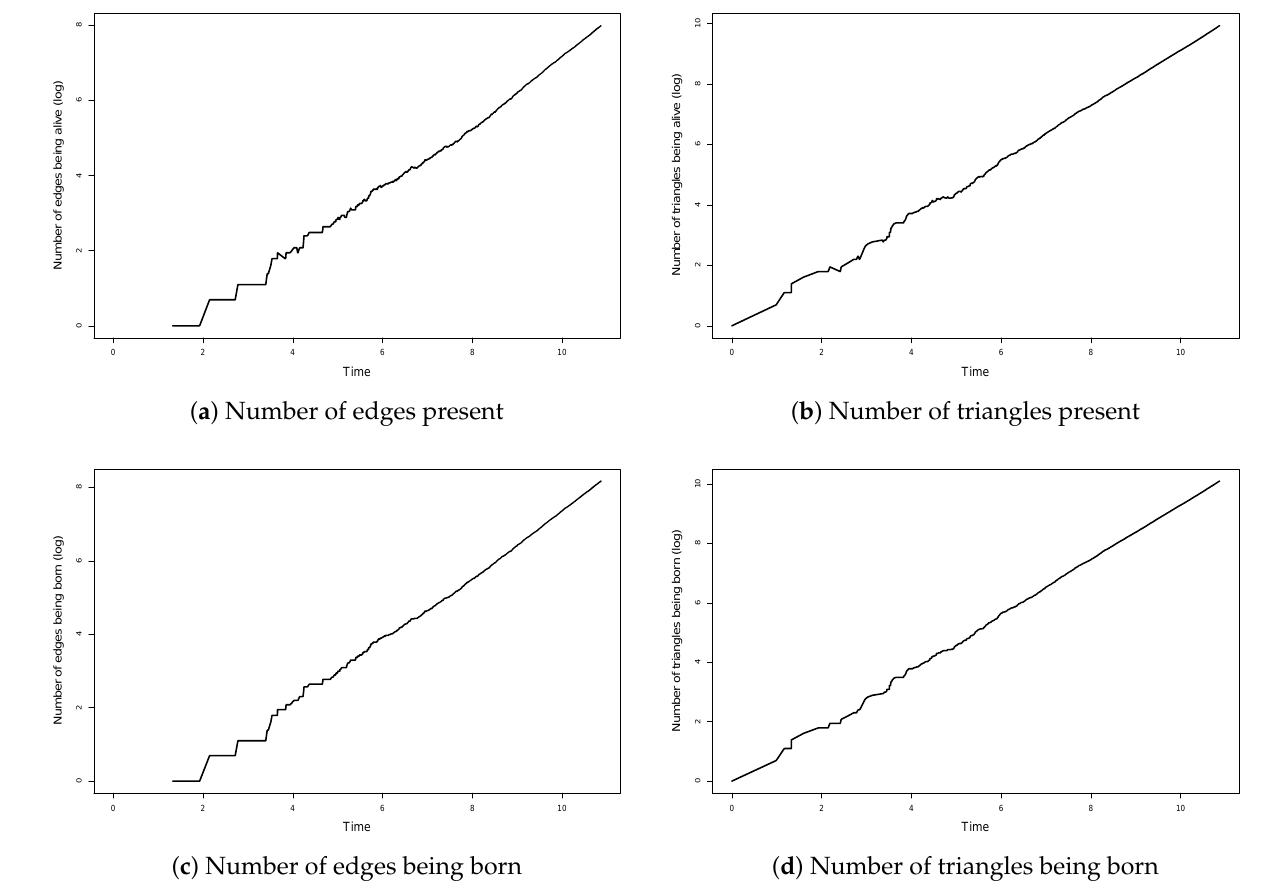
Figure 3. Measurements of a single process on a logarithmic